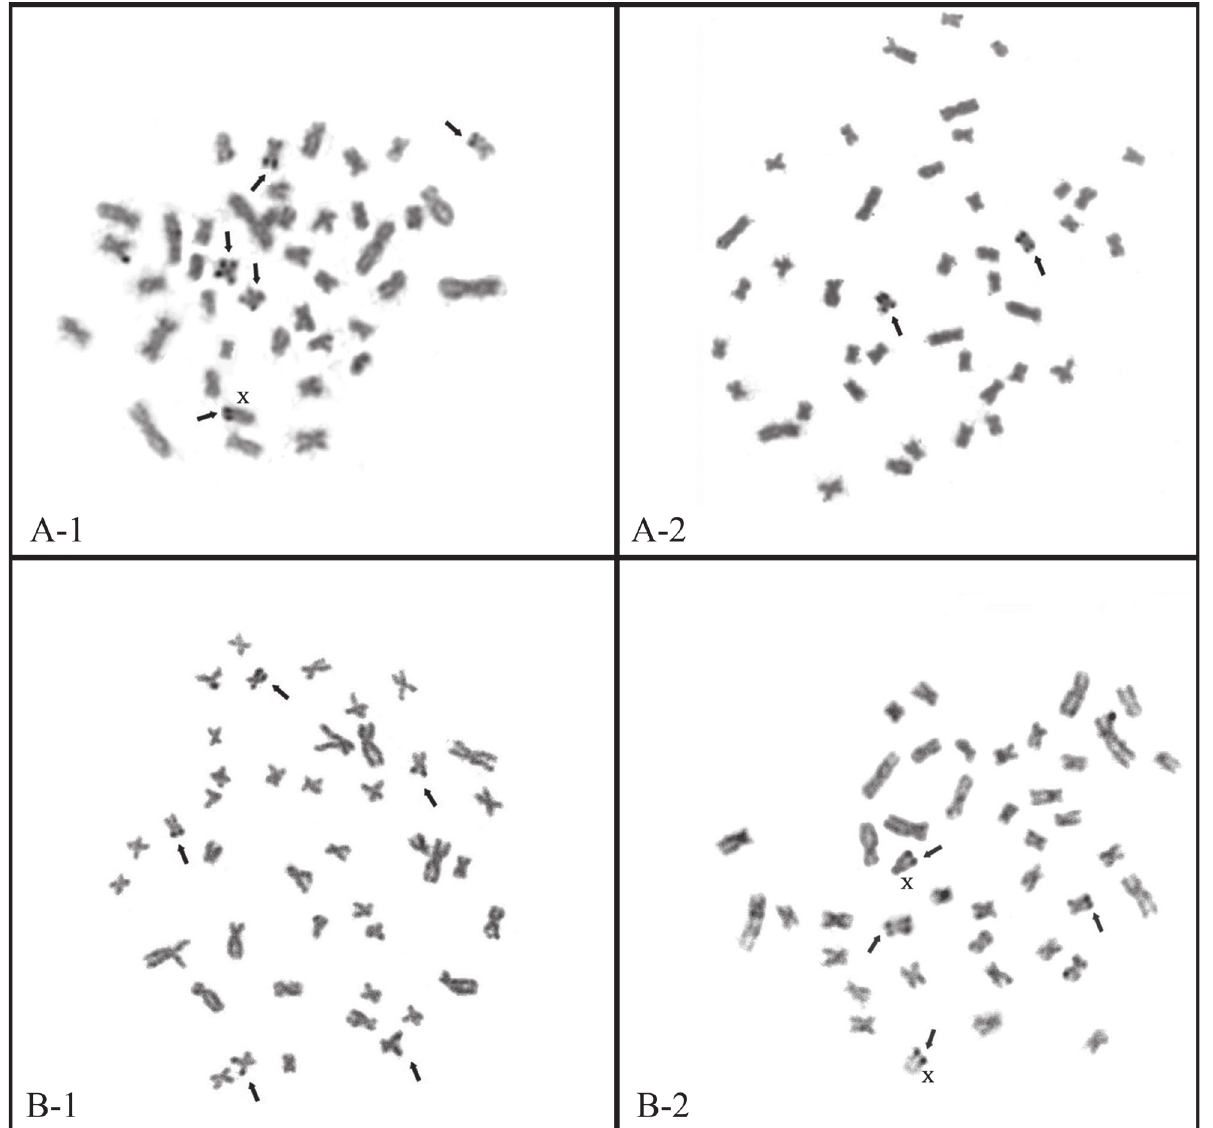
Fig. 3. Variable Ag-NOR patterns in populations of H . malabaricus from middle rio Doce lakes. A-1 , A-2 , and B1 , B-2 male and female NORs.